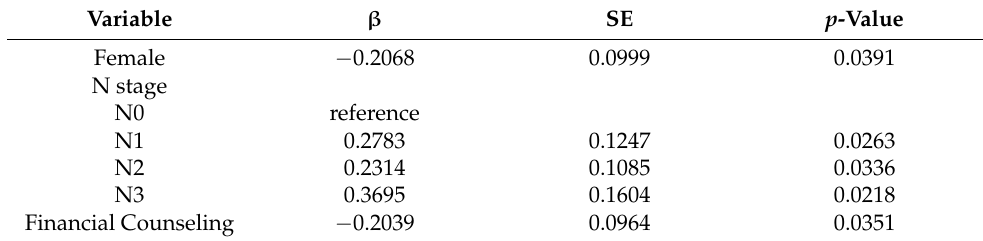
Table 4. Multiple linear regression model for change in financial